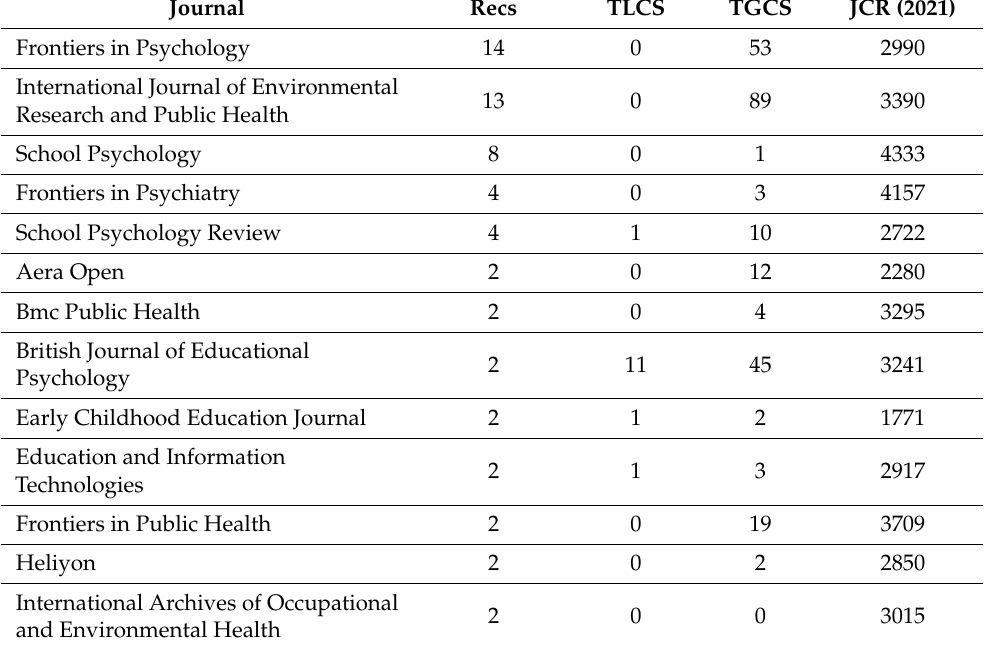
Figure 6. Comparison of countries with the most global citations ( ≥ 40 GCTS). Note: Recs is the number of articles, TLCS is the local citation score and TGCS is the global citation score. Table 3. Journals by the number of publications and citations received (TLCS and TGCS) and the impact factor (JCR) [96] ( ≥ 2